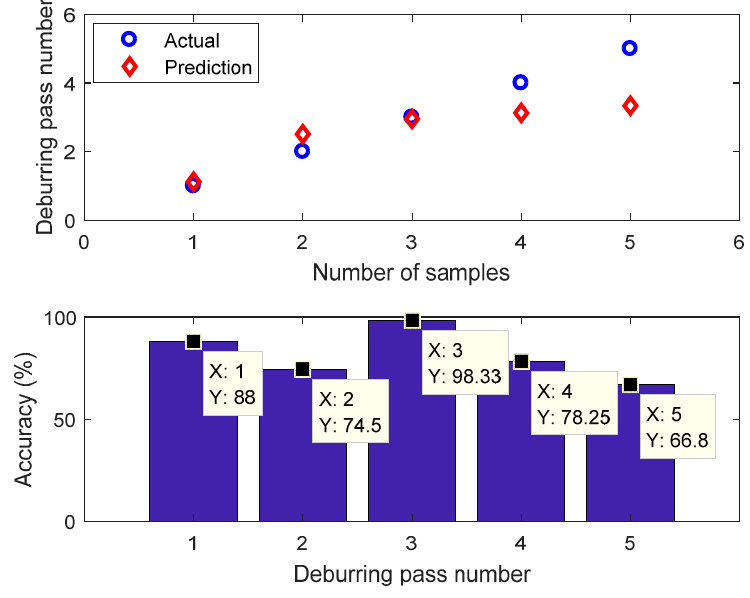
Figure 22. FIS Mamdani prediction.